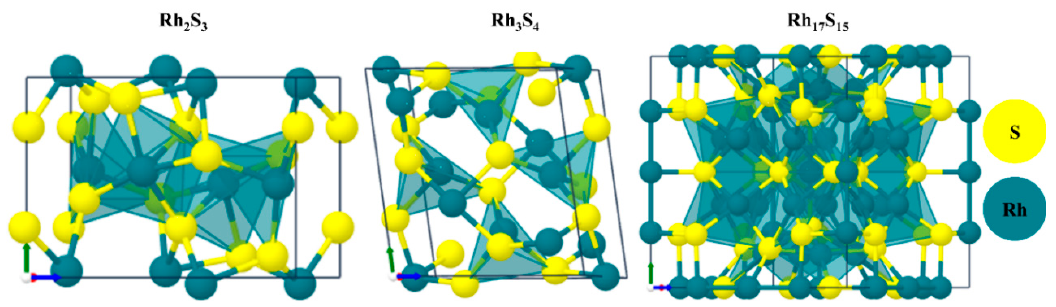
Figure 5. Crystal structures of Rh-S materials [44] (license under by CC-BY 4.0).